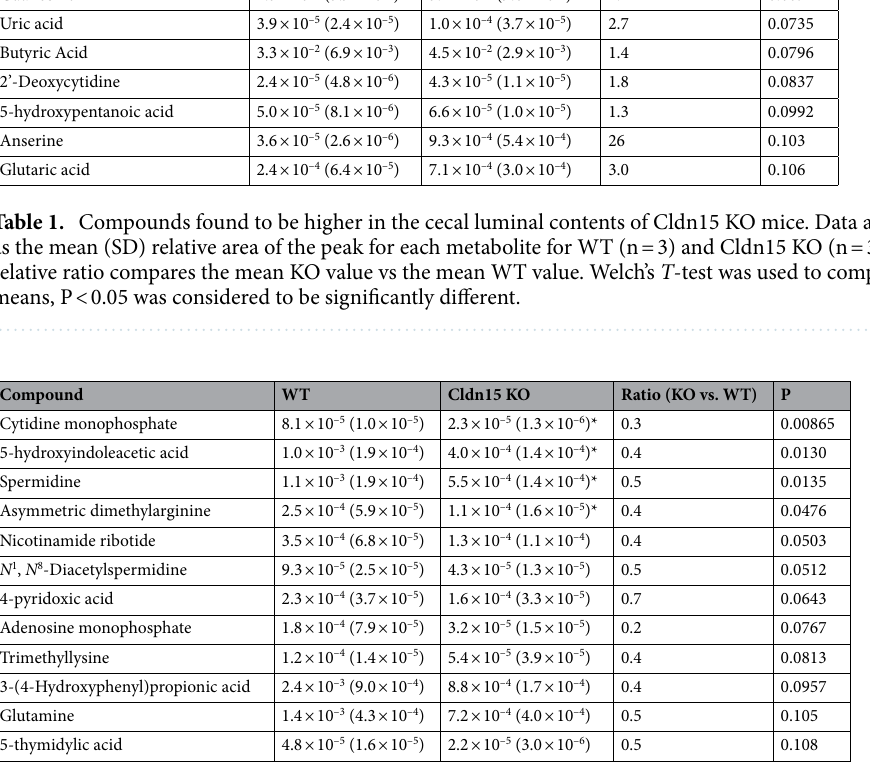
(Fig. 6B, Table 3). The basal I sc was smaller than those flux values (Fig. 5C, 1.5 (0.5) µmol/cm 2 /h), indicating electroneutral Na + absorption is a major Na + absorption mechanism in the middle large intestine, as in the cecum. In accordance with these results, the addition of S3226 to the luminal side resulted in a decrease of M → S flux (Fig. 6B, Table 3). In Cldn15 KO mice, M → S Na + flux did decrease after the addition of S3226 (Fig. 6D, Table 3); however the magnitude of net inhibition was not different compared to WT mice (S3226-sensitive component, 13.3 (11.7) µmol/cm 2 /h and 17.3 (14.5) µmol/cm 2 /h, KO and WT, p = 0.841). In the middle large intestine of